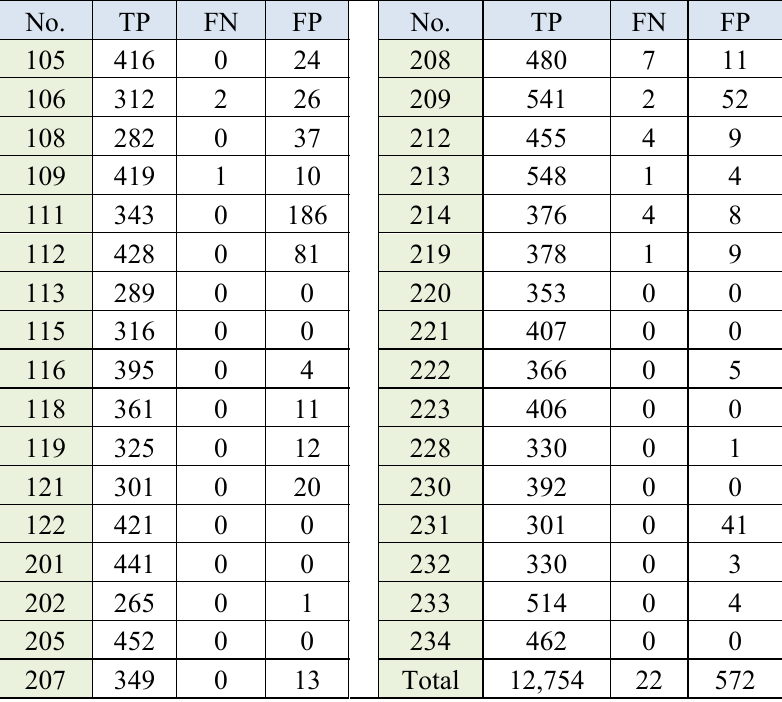
Table 2. Results of marker detection using